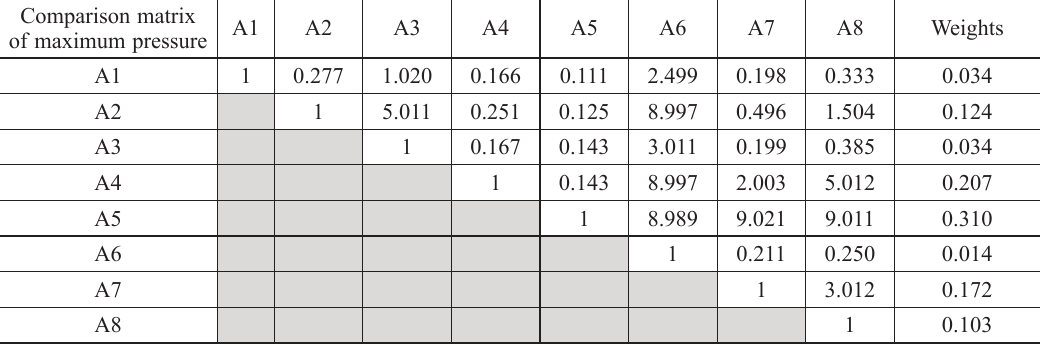
Table 5. Importance degree of any laminated glass models related to pressure of explosion Comparison matrix A1 of maximum pressure